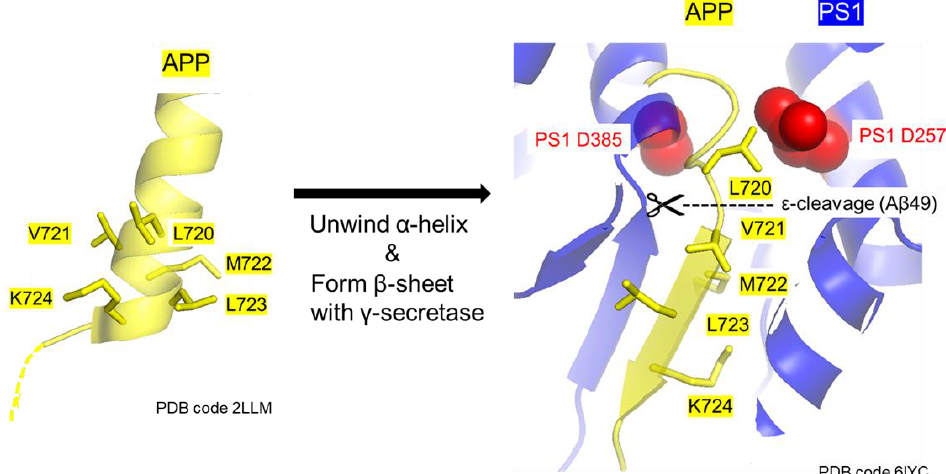
Figure 9. Structure-based models of secondary APP mutations. Structure-based models of the trans- membrane domain of human APP (Protein Data Bank code 2LLM) and the transmembrane core of human APP recognized by γ-secretase (Protein Data Bank code 6IYC) are shown. These models, i.e., PS1 (blue) and APP (yellow), are indicated by a sphere containing the residues Asp257 and Asp385 (red). APP 721 VMLK 724 forms an α-helix that is unwound and forms a β-sheet with γ-secretase when APP is cleaved. The secondary proline mutations (V721 and M722) may facilitate this unwinding.